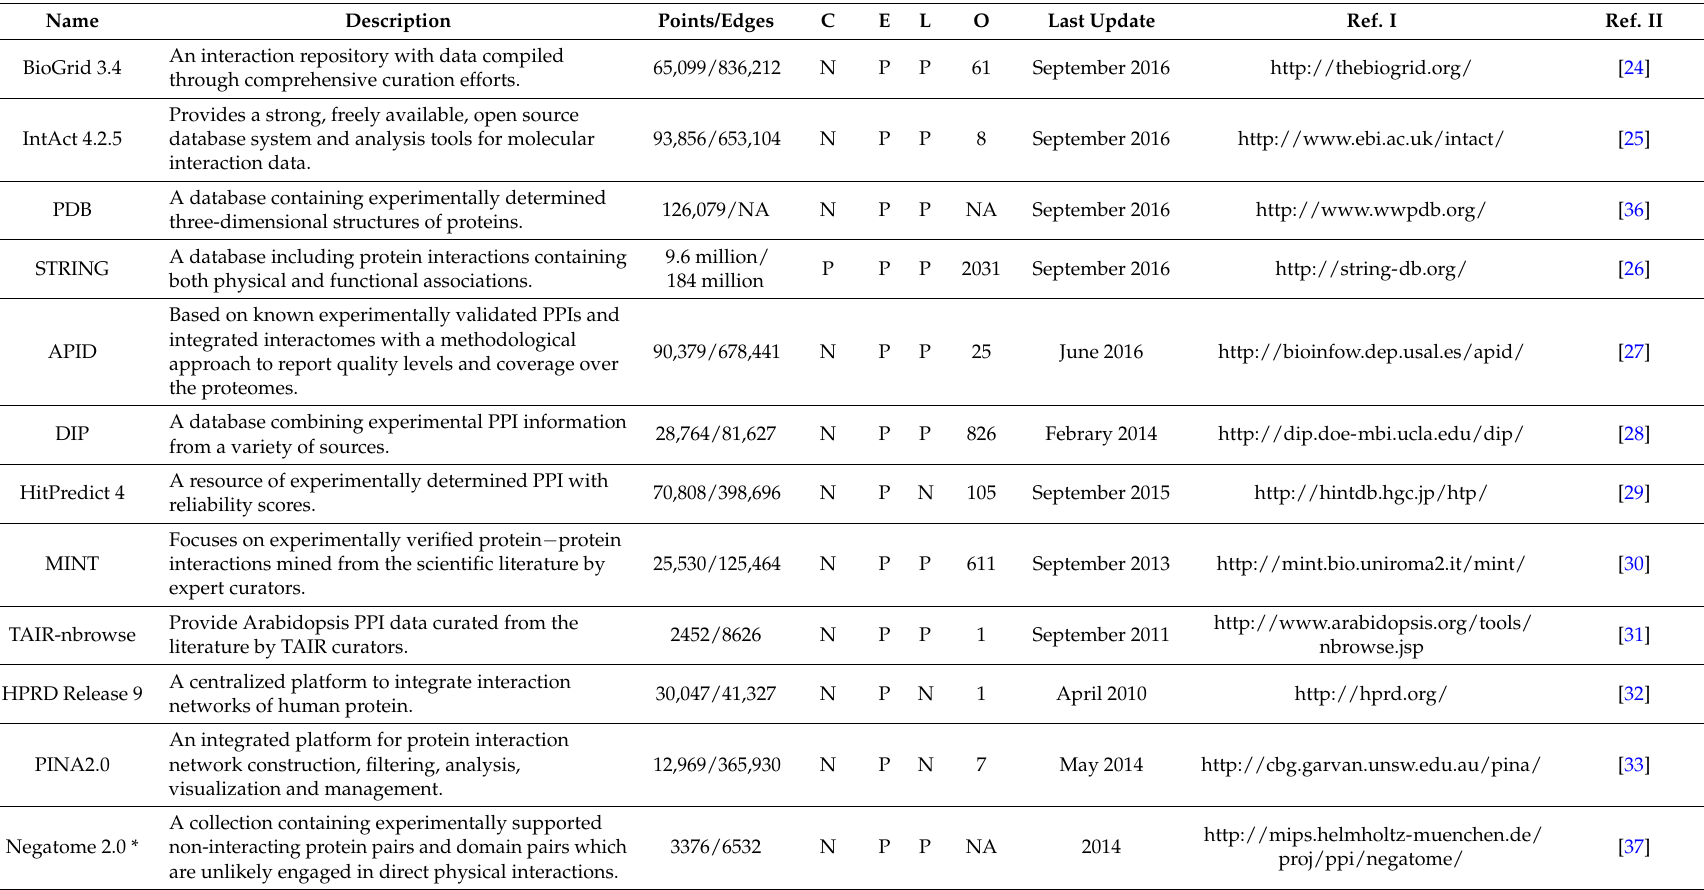
Table 1. Interaction databases for construction of gold standard (until September